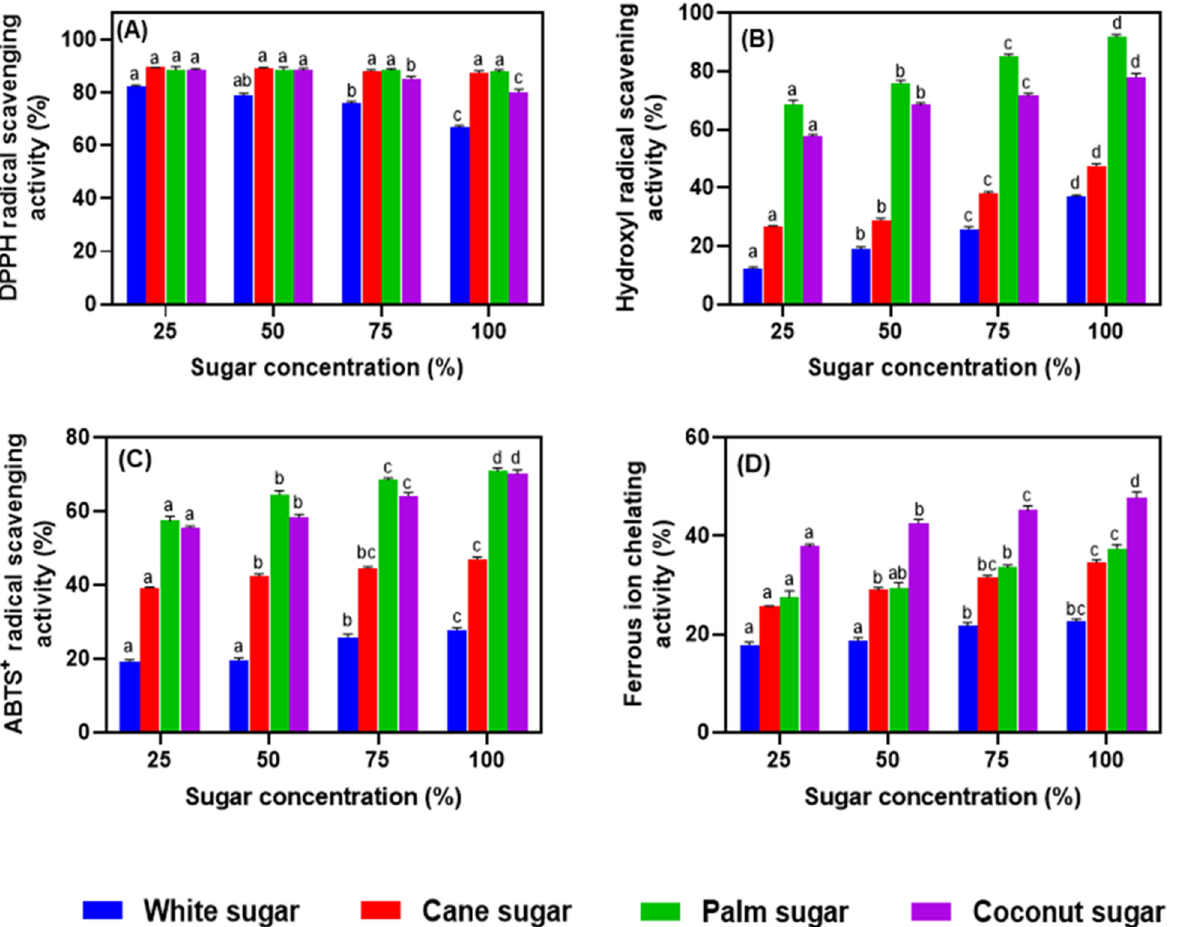
Figure 7. Radical scavenging capacity ( A – D ) of salted duck egg white meringues prepared with alternative types of sugar at various levels in the formulation. Note: DPPH stands for 2,2-diphenyl-1- picrylhydrazyl, and ABTS+ stands for 2,2 (cid:48) -azino-bis (3-ethylbenzthiazoline-6-sulphonic acid). Differ- ent alphabets above the bars indicate significant differences among various